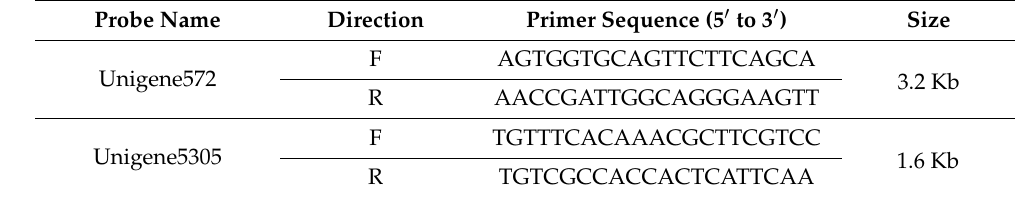
Figure 1. Pipeline in order to design an exon-intron probe for Tyr-FISH. Table 1. Sequences of primers used to produce genomic amplicons for